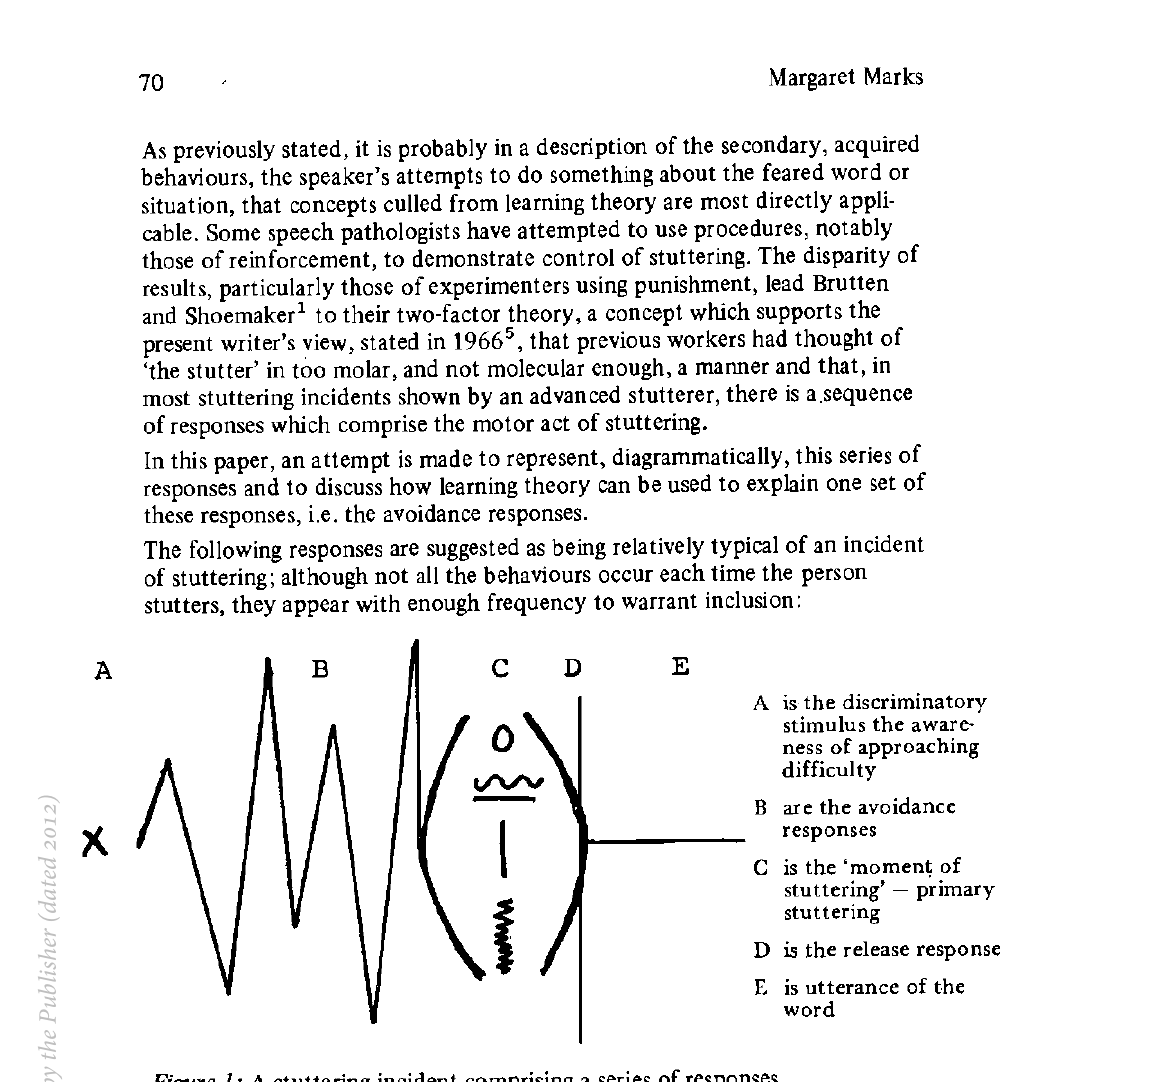
Figure 1: A stuttering incident comprising a series of